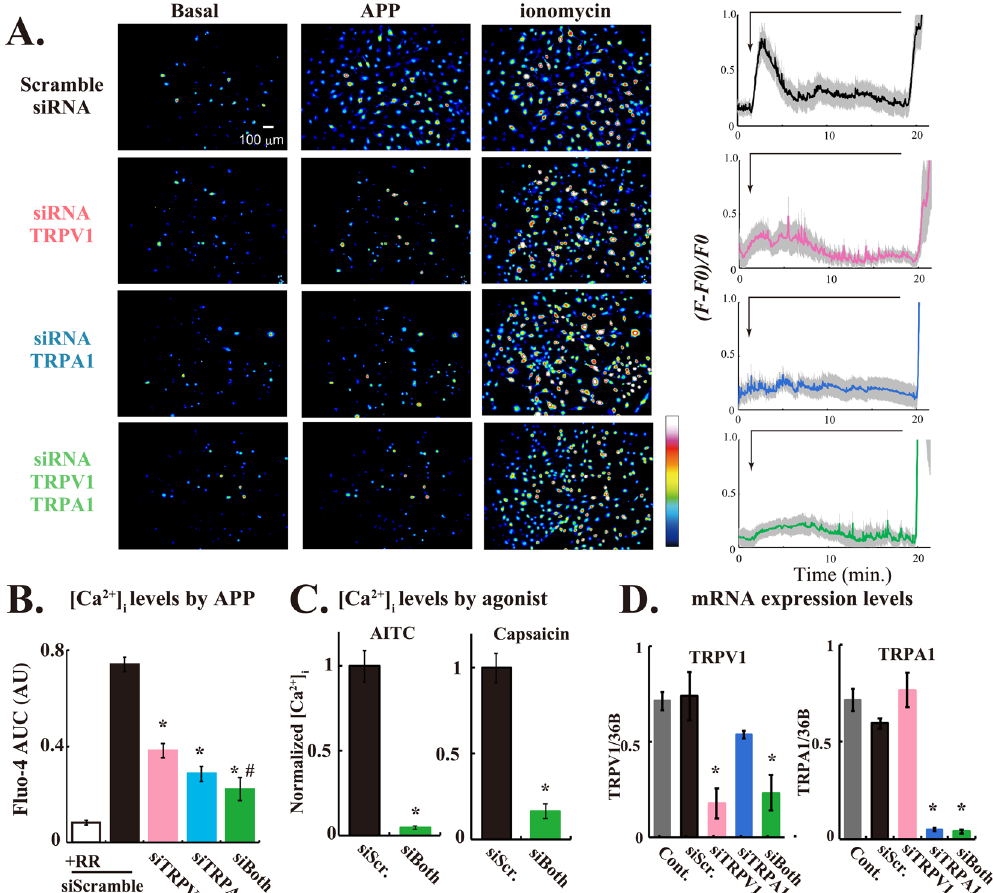
Figure 1. siRNA-mediated TRPV1 and TRPA1 knockdown abrogated the [Ca 2 + ] i transients induced by APP-HBS in 3T3L1 fibroblasts. ( A ) Pseudo-color images showing [Ca 2 + ] i elevation at ~2 min. after APP-HBS exposure in 3T3L1 cells pretreated with scramble, TRPV1, TRPA1 or TRPV1 plus TRPA1 siRNAs. The cells were stimulated with APP-irradiated HBS at ~1 min. (allows), followed by treatment with ionomycin. The pseudo-color coding on the right shows Fluo-4 fluorescence intensity. The graphs on the right represent mean changes in [Ca 2 + ] i within all cells in the images shown on the left, which were expressed as (F − F0) / F0 as described in Materials and Methods. The thick colored lines represent the mean values, the shaded region the SE. ( B and C ) Quantification of the indirect APP-responsive or agonist-induced [Ca 2 + ] i transients obtained from 3–5 independent experiments. For each experiment, more than 50 cells from each glass-bottom dish were measured. ( B ) The area-under-the-curve (AUC) of the (F − F0 )/ F0 values from 1 to 6 min are shown. ( C ) Normalized [Ca 2 + ] i levels of the AUC in siRNA-treated 3T3L1 cells stimulated with AITC or capsaicin are shown. Statistical analysis was performed, versus the control (scramble siRNA), using Dunnett’s multiple comparison and statistical significance is indicated by * (P < 0.05). # Denotes a statistically significant difference (P < 0.05) between the TRPV1 alone and the TRPA1/TRPV1-double knockdown. ( D ) Quantification of TRPV1 and TRPA1 mRNA expression levels in 3T3L1 fibroblasts pretreated with scramble, TRPV1, TRPA1 or TRPV1 plus TRPA1 siRNAs. Statistical significance was determined by applying the Dunnett’s multiple comparison versus the control. The effects of siRNA-mediated knockdown of TRPV1 (pink), or TRPA1 (blue), or both (green) are indicated by * ( P <